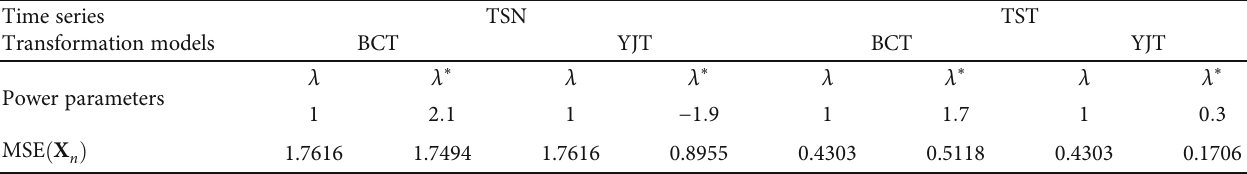
Table 2: Optimal parameters of the two transformation models and MSE estimates of the last curve of functional variable X series datasets.